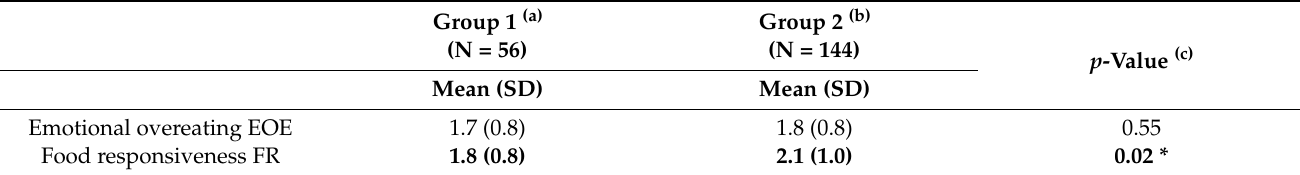
Table 6. The differences in children’s eating behaviour by parental combined weight